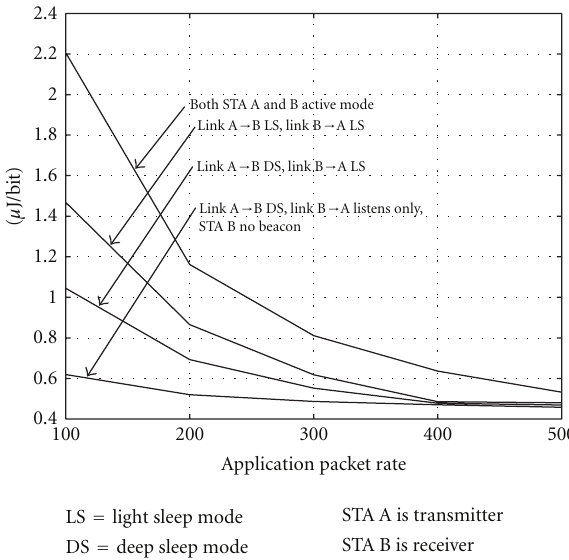
Figure 11: Sleep per packet distribution.